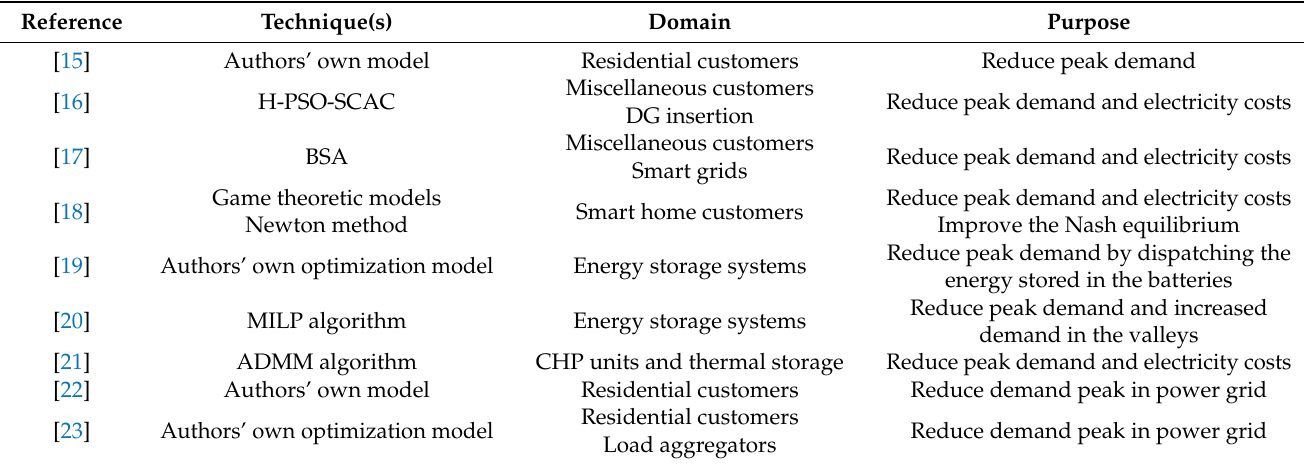
Table 1. General summary of the works cited in the literature review. Source: The